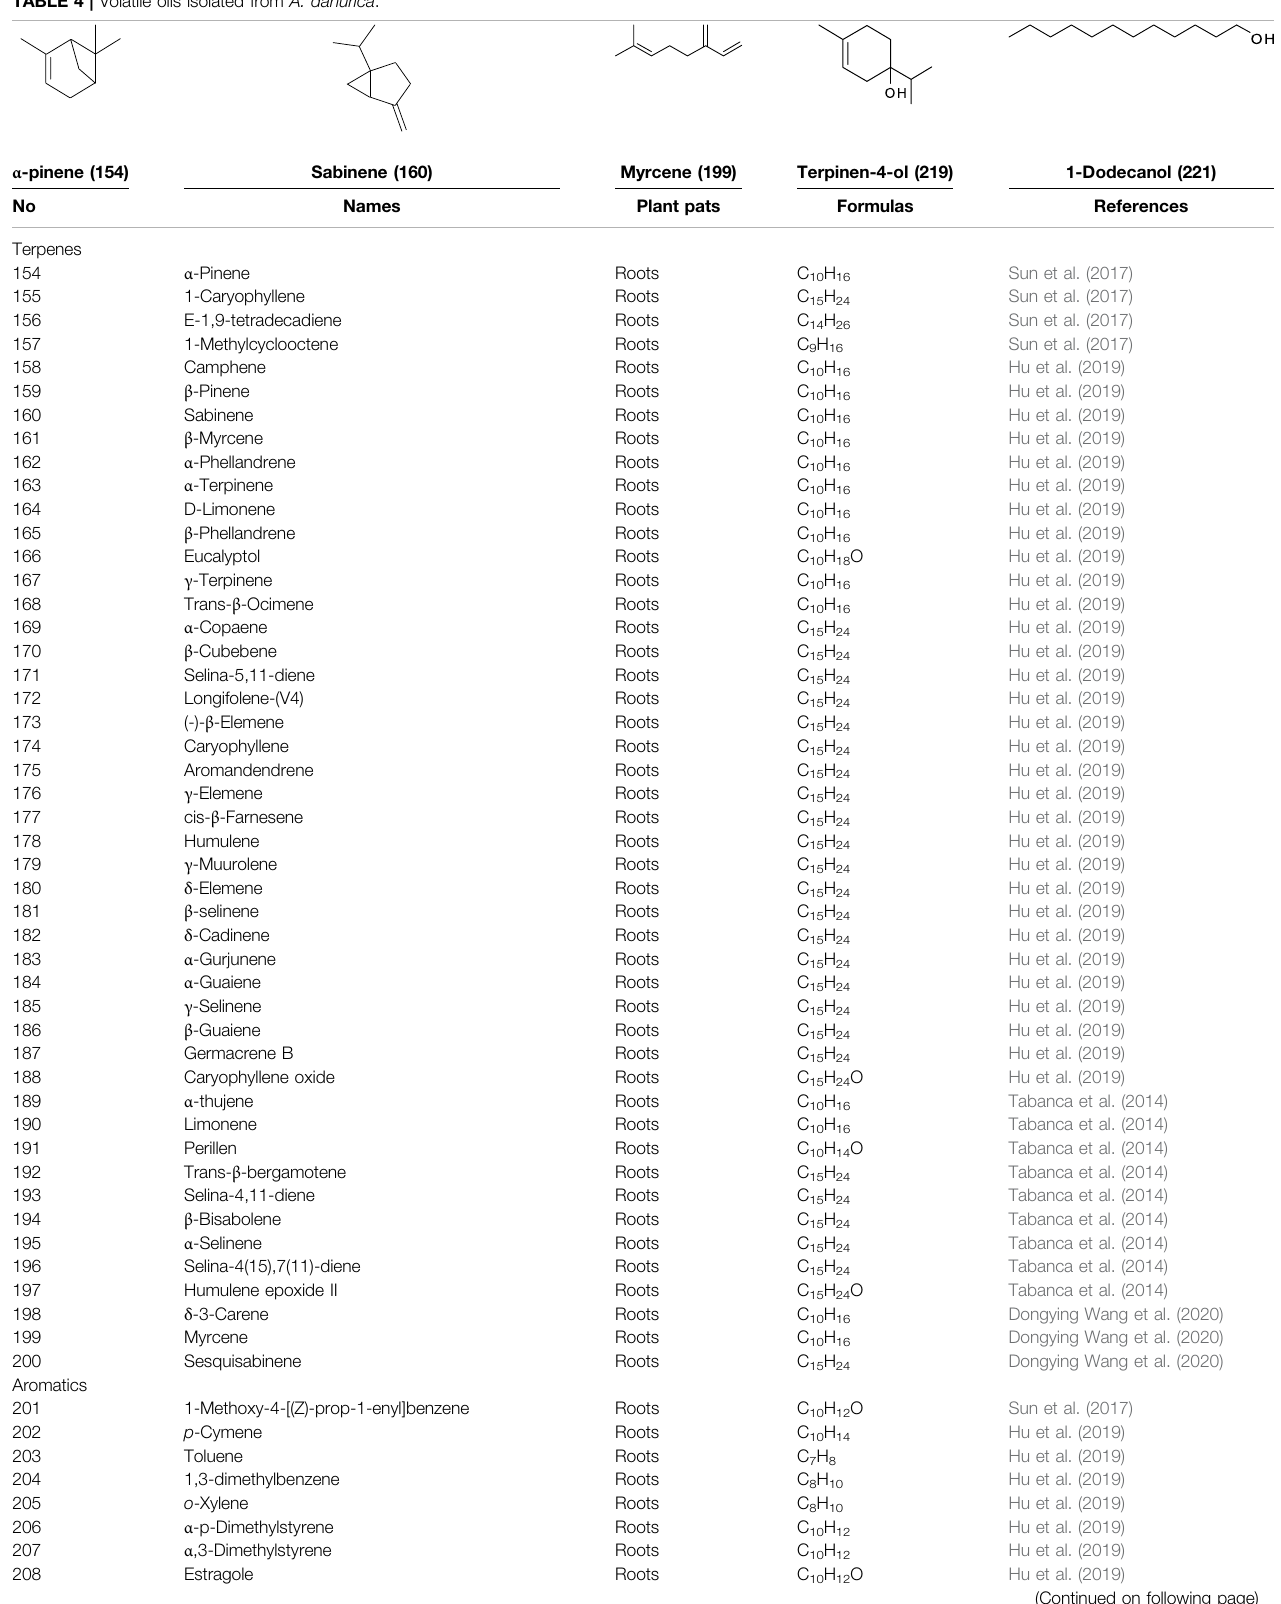
TABLE 4 | Volatile oils isolated from A. dahurica .